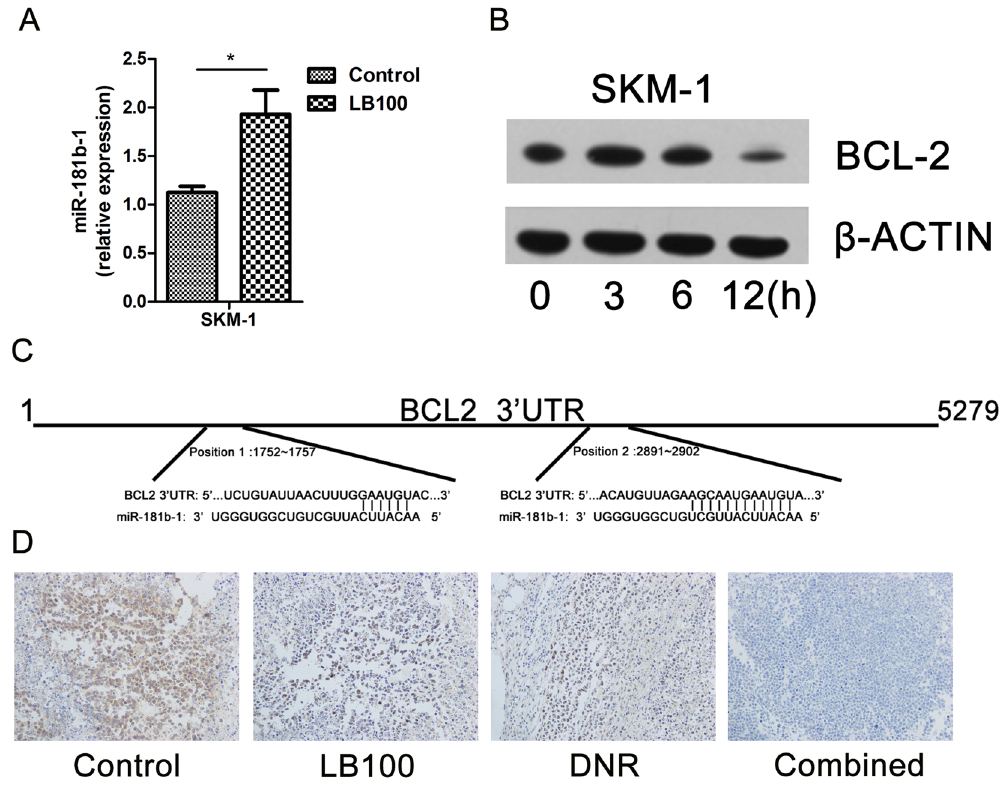
Figure 5. LB100 induces expression of miR-181b-1, and suppresses expression of Bcl-2. ( A ) qRT-PCR demonstrated that LB100 upregulated miR-181b-1 in SKM-1 cells. ( B ) Western blot demonstrated decreased Bcl-2 expression after 5 μ M of LB100 treatment for 0, 3, 6 and 12 h. β -ACTIN served as an internal control. ( C ) TargetScan predicted miR-181b-1 sequence complementarity to the 3 ′ untranslated region of Bcl-2 mRNA. ( D ) SKM-1 xenograft histology demonstrates decreased immunoreactivity to Bcl-2 after LB100 treatment. Statistically significant differences are marked by an asterisk ( * P <